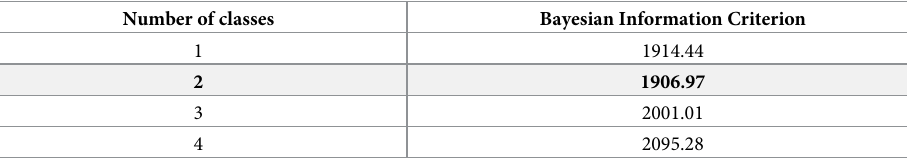
Table 4. Latent class models and Bayesian Information